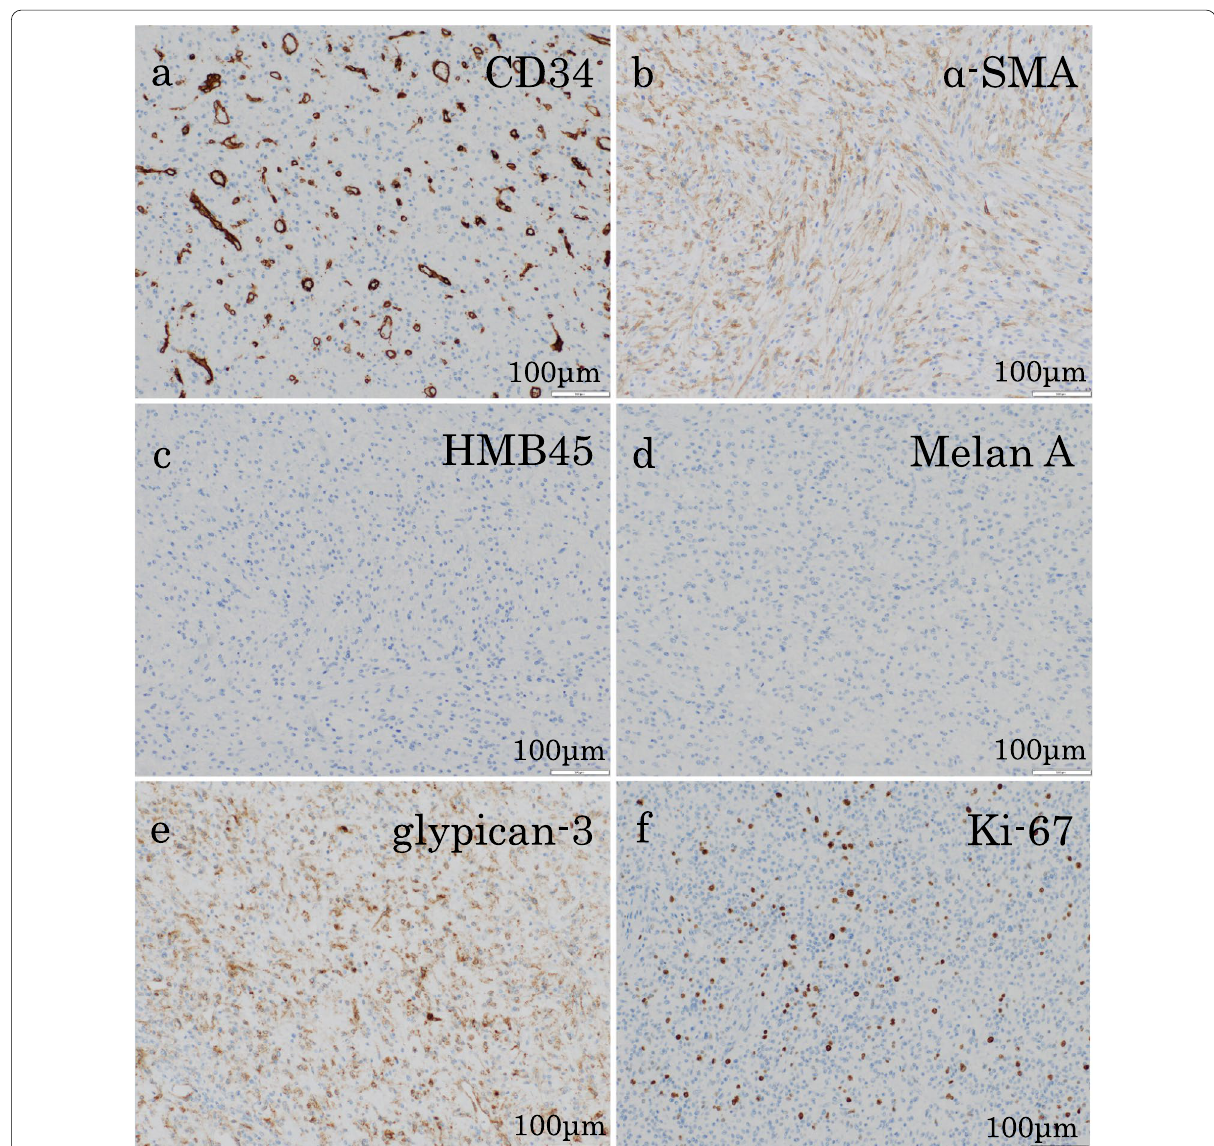
Fig. 5 Immunohistochemistry. a , c , d The tumor cells are negative for CD34, HMB45, Melan A. b , e The tumor cells are positive for α‑SMA, glypican‑3. f Ki‑67 index is 10% (hot